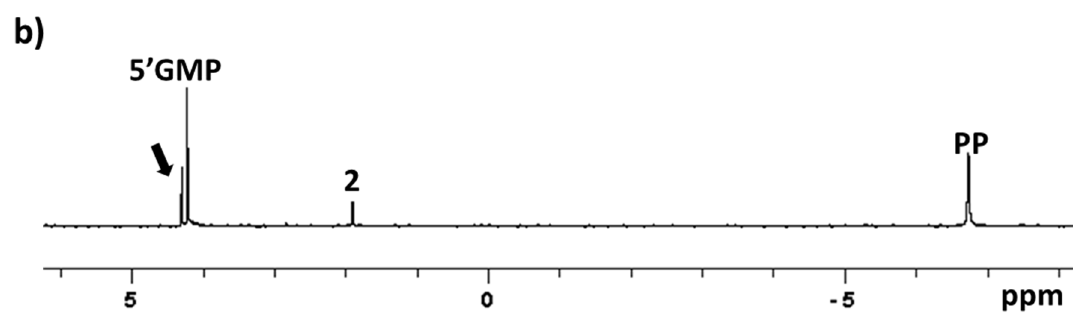
Figure 9. ( a ) 31 P NMR spectra (121.5 MHz) at different time intervals of 2 (5 mM) in the presence of 5’-GMP (12.5 mM) at